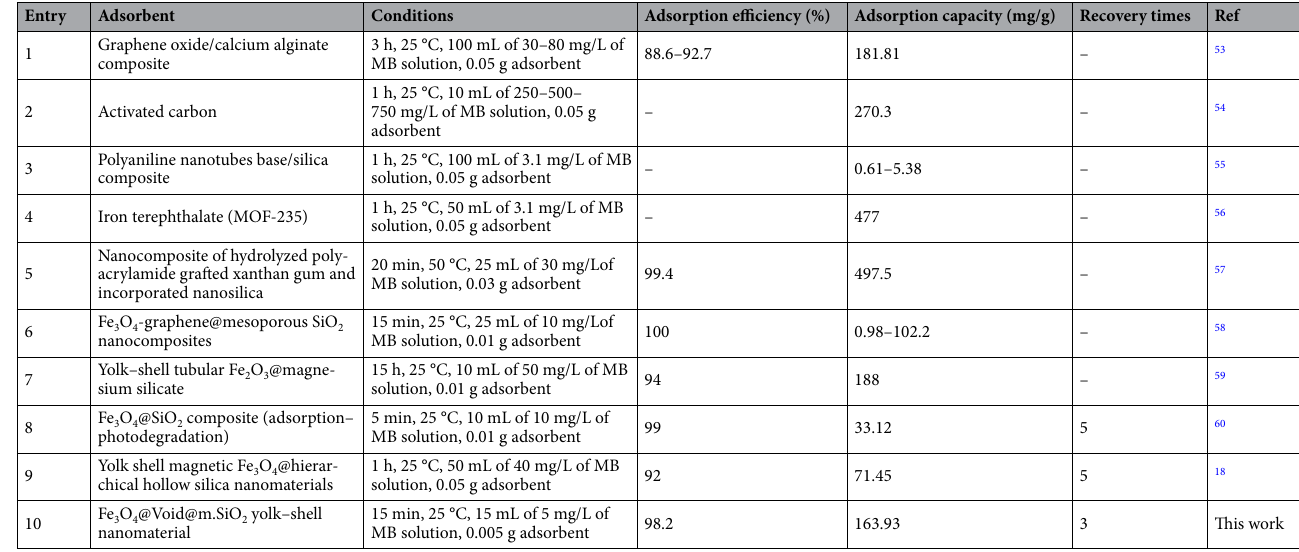
Table 4. A comparison study between present adsorbent and previously reported adsorbents in the MB